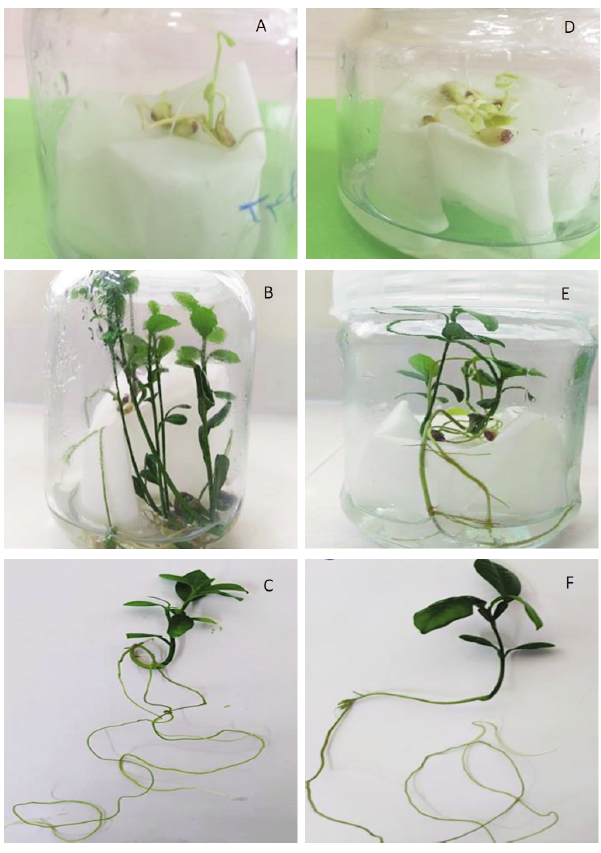
Fig. 2 ­ In vitro seed germination and plantlet growth. Germinated seeds of Mexican lime (A) and Sour orange (D) in darkness, 170 and 230 days after flowering respec­ tively. Plantlets growth of Mexican lime (B, C) and Sour orange (E, F) after 4 weeks in light, 140 and 230 days after flowering